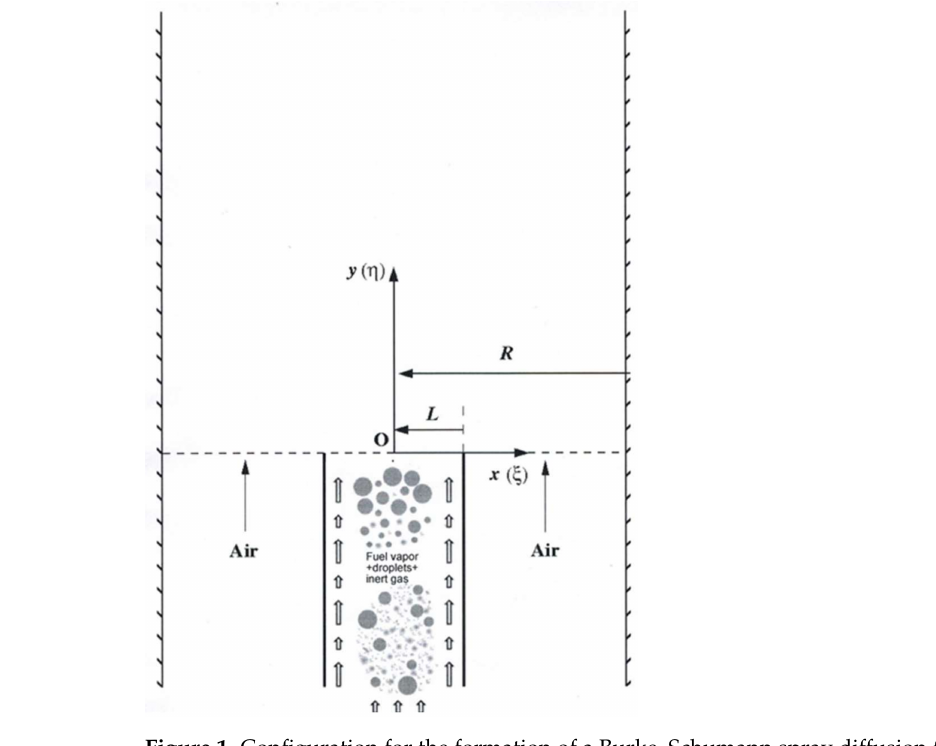
Figure 1. Configuration for the formation of a Burke–Schumann spray diffusion flame schematically showing fuel droplet grouping due to local variations in gas